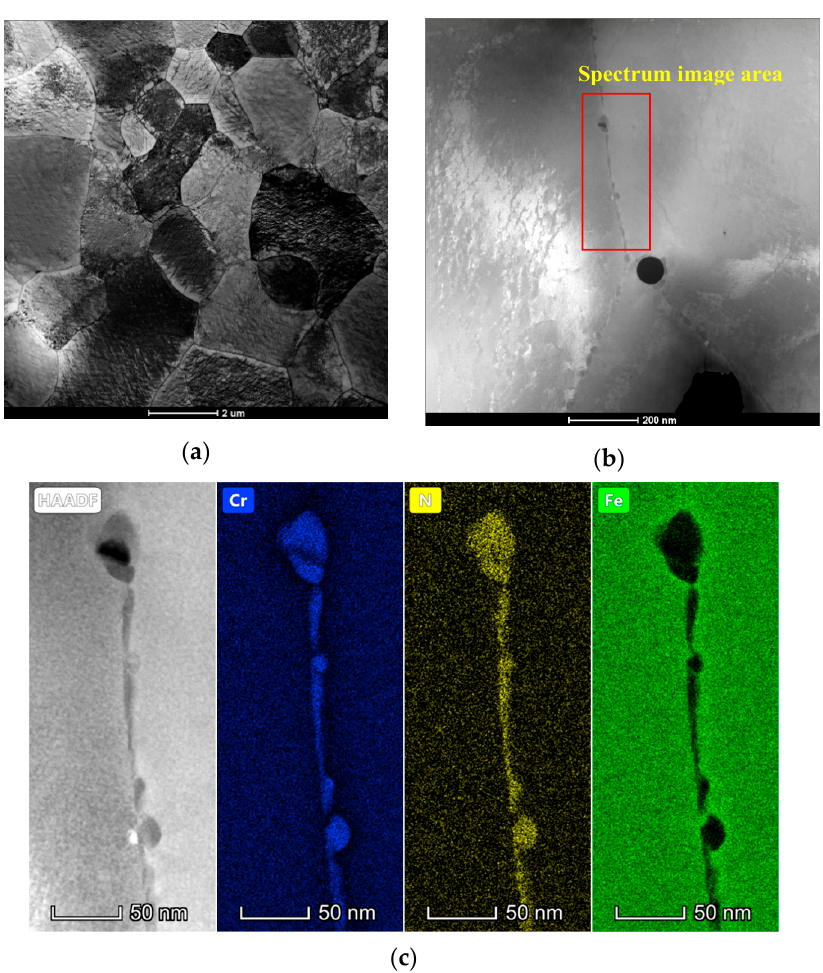
Figure 2. TEM morphology of the S1 sample ( a ) TEM bright field image; ( b , c ) scanning transmission electron microscope-energy dispersive spectrometer (STEM-EDS) mapping image.